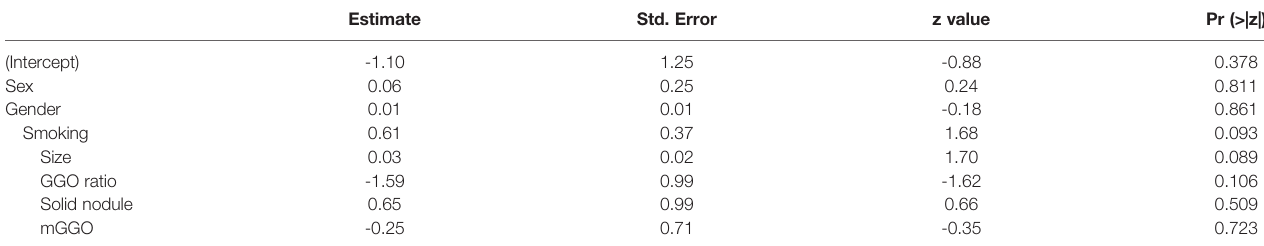
TABLE 2 | Features included in the clinical-CT model and their coef fi cients. Estimate Std.